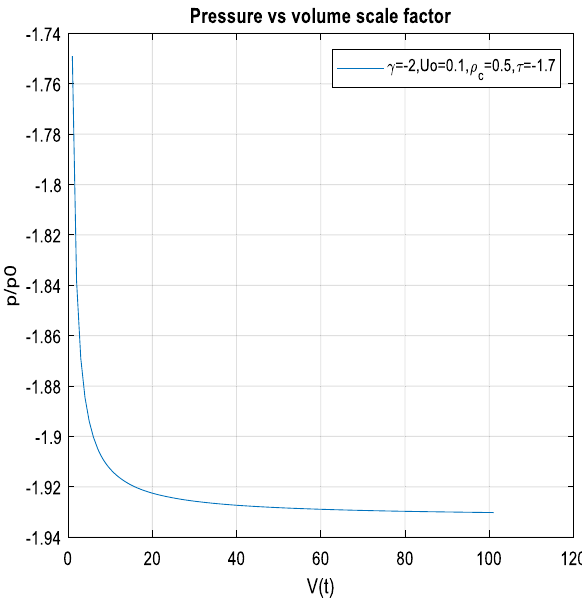
Fig. 7 Graph for pressure; γ = − 2 ; U 0 = 0 . 5 ; τ = − 1 . 7